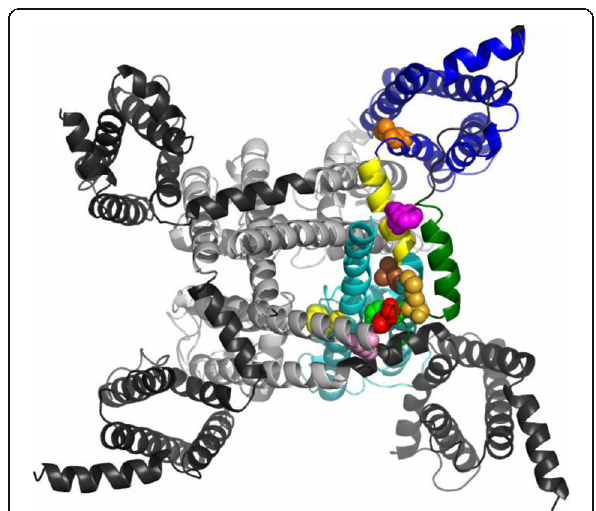
Fig. 1 Mapping of mutants on the Na + channel structure. The structure of the human skeletal muscle sodium channel Nav1.4 [32] is shown in cartoon structure. Domains I-III are shown in gray (voltage-sensor domains in dark gray, pore domains in light gray). The linker between domain III and IV is shown in green. For domain IV, the voltage sensor domain (S1-S4) is shown in dark blue, the pore domain in light blue and the linker S4-S5 in yellow. Residues corresponding to those studied here are shown in space fill: Q1489: light pink; I1498: red; F1499: green; M1500: light brown; L1649: orange; F1661: pink; F1774: